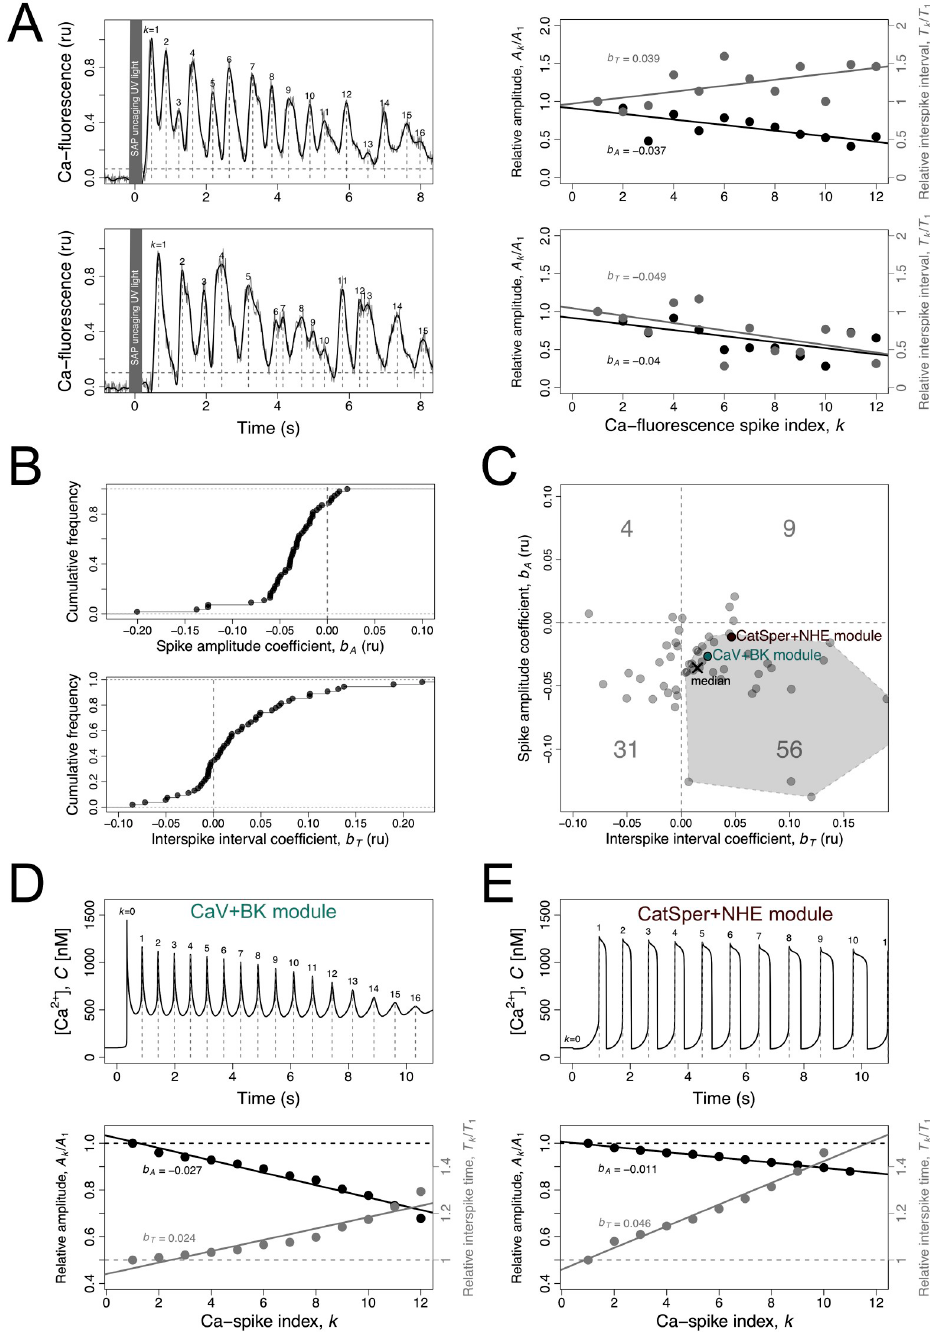
Fig 3. [Ca 2+ ] i -spike trains produced by the sperm activating peptides in sea urchin sperm flagellum and its modelling. A) On the left, two examples are shown of [Ca 2+ ] i time series measured with fluorescent probes in flagella of S. purpuratus individual sperm bound to a coverslip following uncaging of Speract analogue by UV light. The raw measurements (grey) were smoothed using cubic spline (black). The Ca-spikes (vertical grey dashed lines) were calculated as the maxima in the smooth curve higher than 3x the standard deviation of the measurements pre- uncaging (horizontal gray dashed line). For each spike indexed k , the amplitude A T k = t k +1 − t k were calculated. The shaded region indicates the UV light pulse. On the right, the relative spike amplitude A k / A 1 (left axis; black) and relative interspike interval T k / T 1 (right axis; grey) are plotted as a function the spike index k for the two examples. The lines are linear regressions of the relative spike amplitude (black) and relative interspike interval (grey) over the spike index k from which the respective regression coefficients b